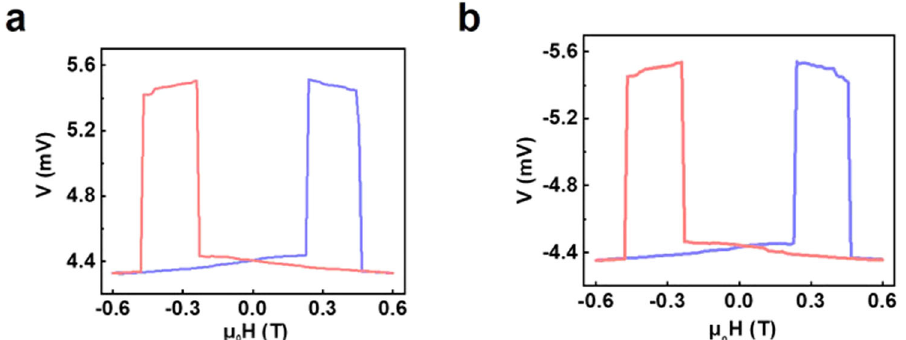
Fig. 4 MR response of FGT/WSe 2 (6.9 nm)/FGT with ± 1 μ A. a FGT/WSe 2 (6.9 nm)/FGT spin valve effect with + 1 μ A at 10 K. b FGT/WSe 2 (6.9 nm)/ FGT spin valve effect with − 1 μ A at 10 K.